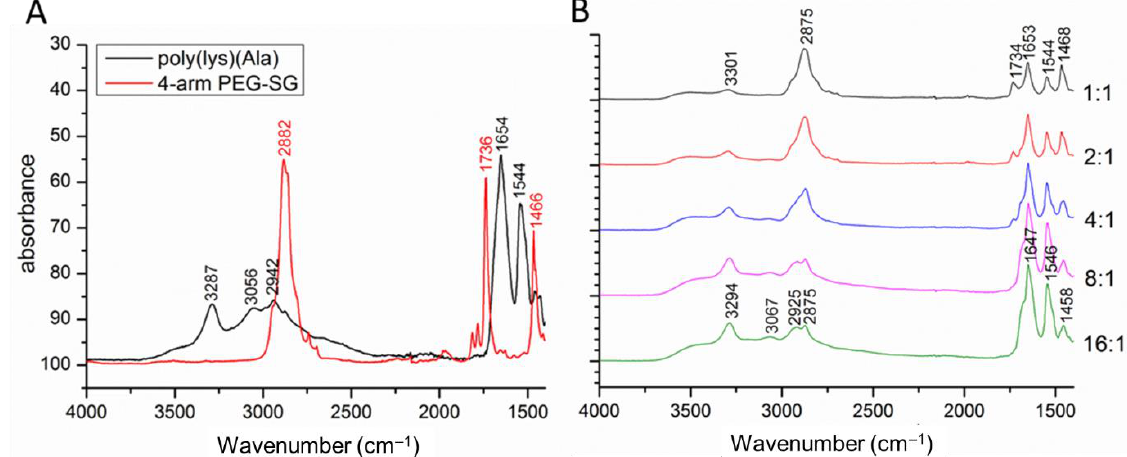
Figure 4. FTIR spectra of ( A ) starting materials and ( B ) hydrogels of 8 wt% with varying molar ratios .